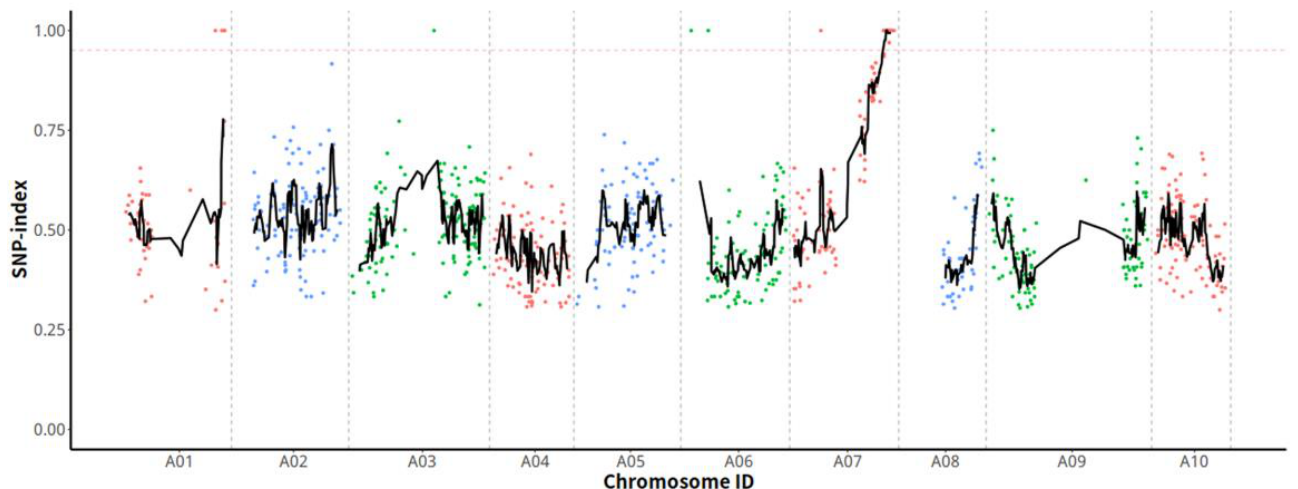
Figure 2. The distribution of SNP index on chromosomes. SNP index on 10 chromosomes based on Mutmap analysis. The x -axis represents the chromosome position. The y -axis represents the SNP index value. The black line is the mean value of the SNP index under the window. The pink dashed line is the threshold line of SNP index (0.92). Table 2. Candidate SNP information in the candidate region by Mutant analysis.